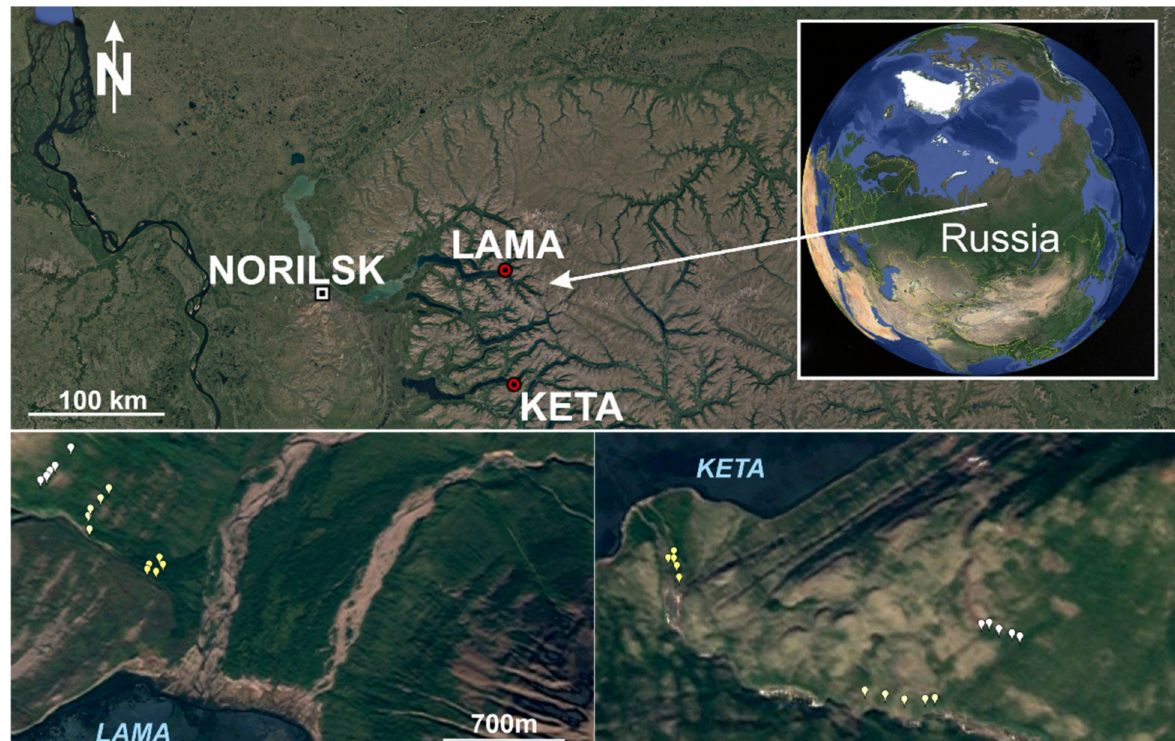
Figure 10. Location of sample plots in Russia, at Lama and Keta lakes (Krasnoyarsk